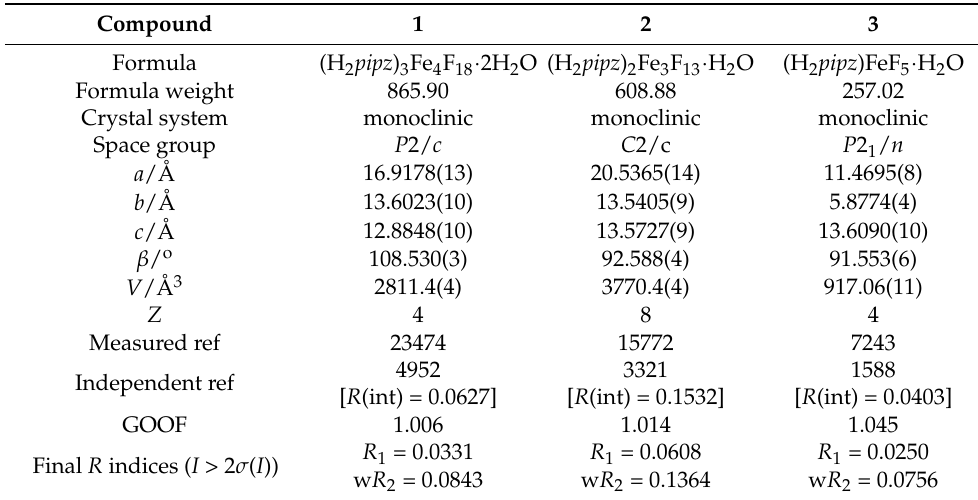
Table 1. Crystal and Structure Refinement Data for 1 , 2 and 3 at